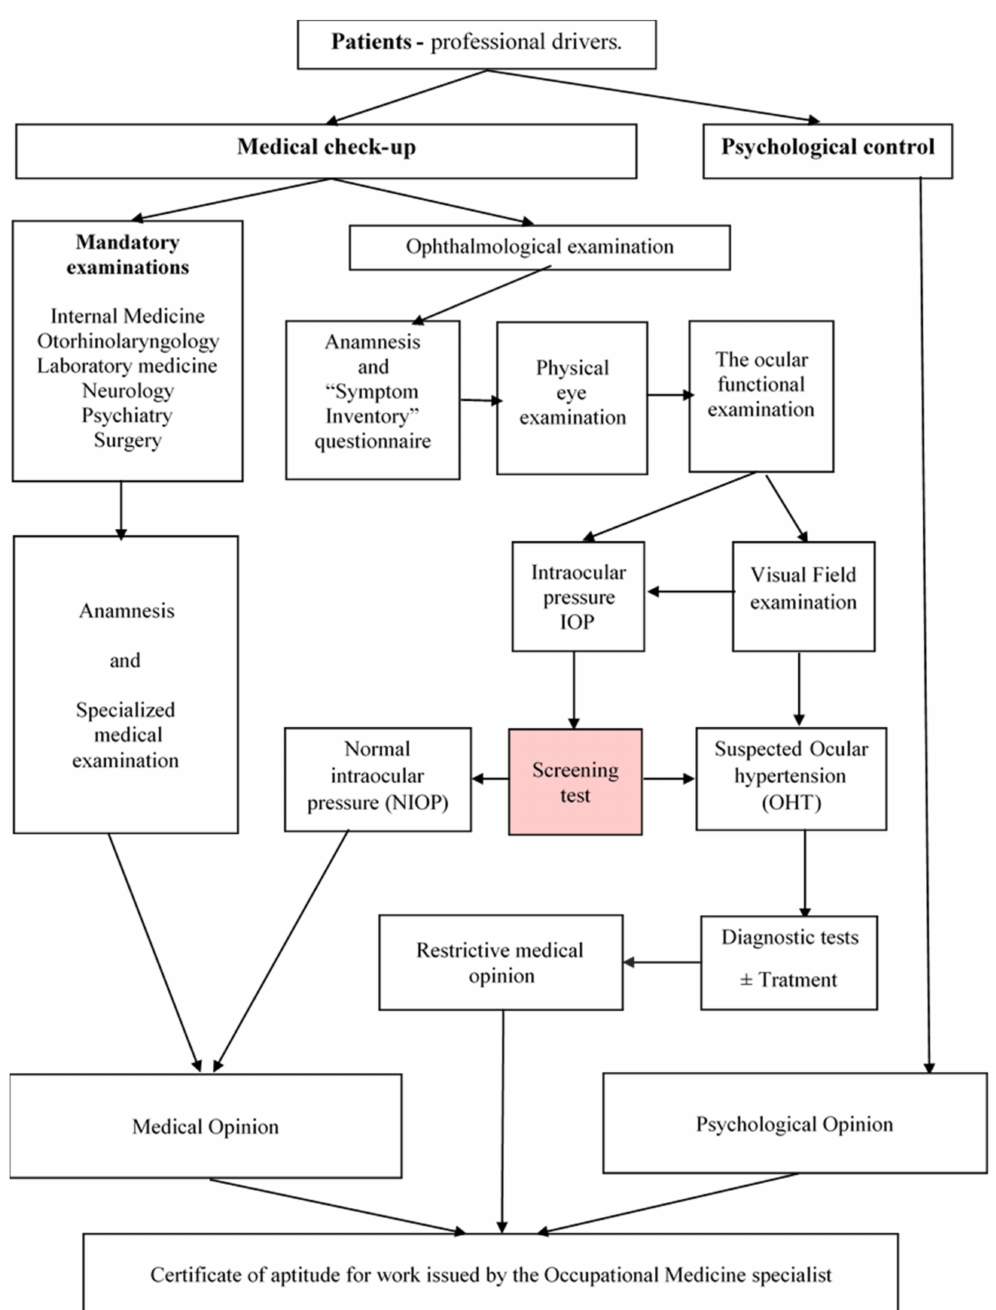
Figure 1. Staging research on the detection of OHT Screening (Red box—Screening test, highlights the main point of the screening